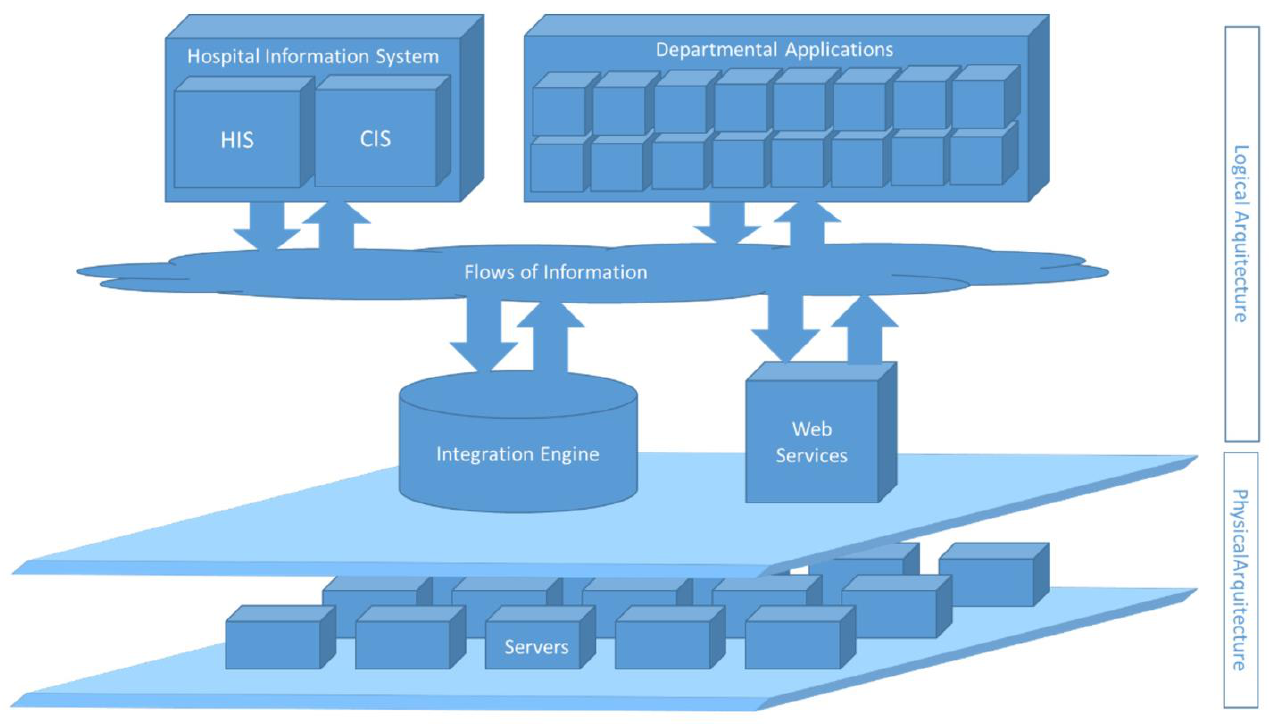
Figure 9. Proposed architectural scheme.